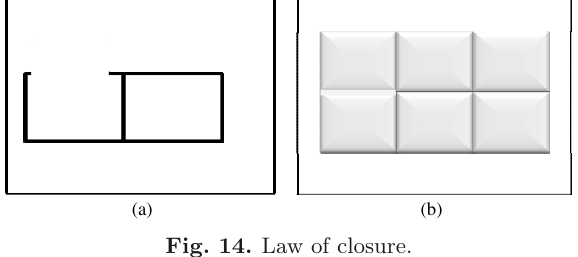
Fig. 15. Law of closure: impact of an anomaly.